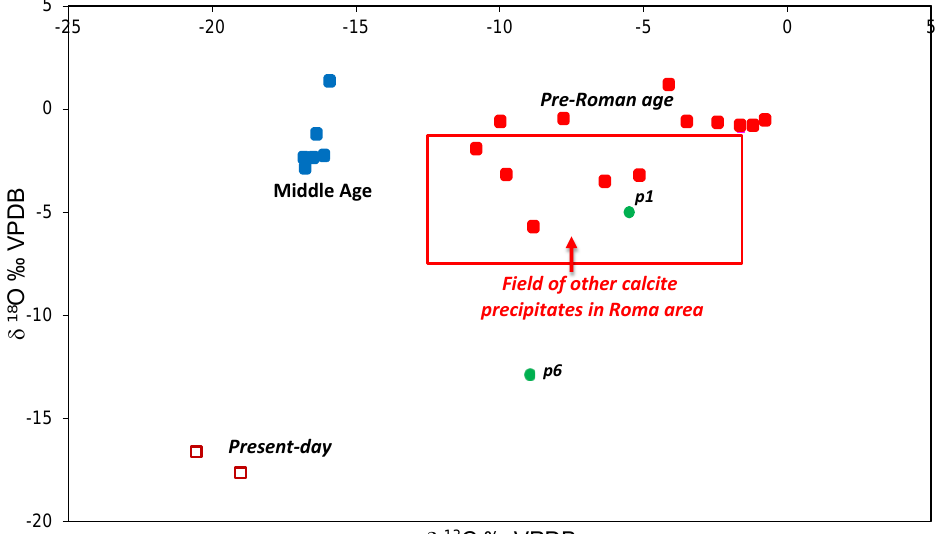
Figure 8. δ 13 C versus δ 18 O of calcite precipitates (p1 and p6) in Ostia Antica stratigraphic sequence compared with other calcite in sediments, aqueducts, and caves of the Roma area (Italy). Squares represent calcites layers of different ages in the pre-Roman remains of the ancient Portuense road ([40,42,43] and Tuccimei, unpublished data).